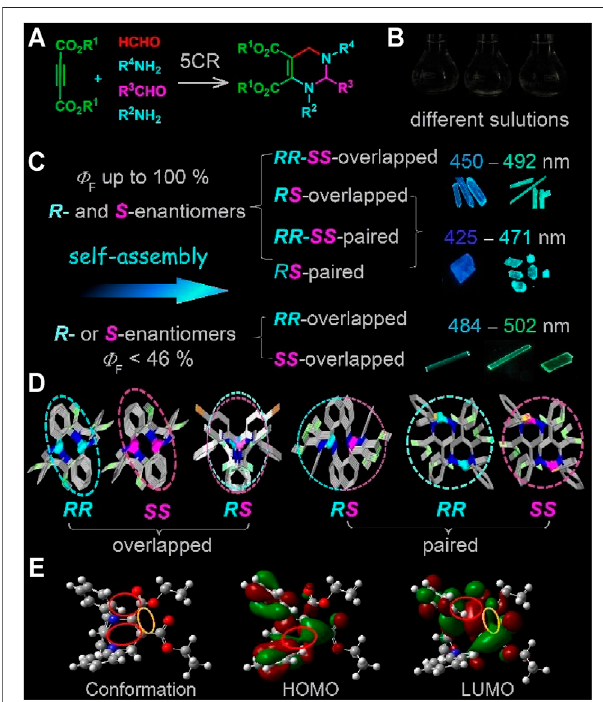
FIGURE 1 | Synthesis of tetrahydropyrimidines (THPs) and their aggregation-induced emission (AIE) characteristics. (A) The 5CR for the synthesis of THPs (Zhu et al., 2013). (B) Photos of THPs in n -hexane (Zhu et al., 2019), cyclohexane (Zhu et al., 2015), and ethanol (Zhu et al., 2013). (C) R - and S -enantiomer packing modes of THPs and their in fl uence on fl uorescence quantum yields and emission wavelengths. (D) Examples of R - and S -enantiomer packing modes in THP single crystals (Zhu et al., 2019). Reproduced with the permission of Elsevier. (E) Through-space conjugation (marked in color circles) in the HOMO and LUMO calculated from the conformation of THP-1c crystal (Zhu et al., 2015). Reproduced with permission from the Royal Society of Chemistry. The photos in (B) and (C) were taken under a 356 nm